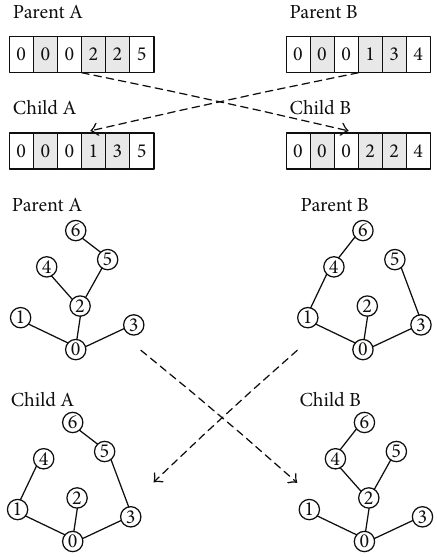
Figure 3: Two individuals performed crossover, where the 2rd, 4th, and 5th genes are chosen to perform crossover [9].